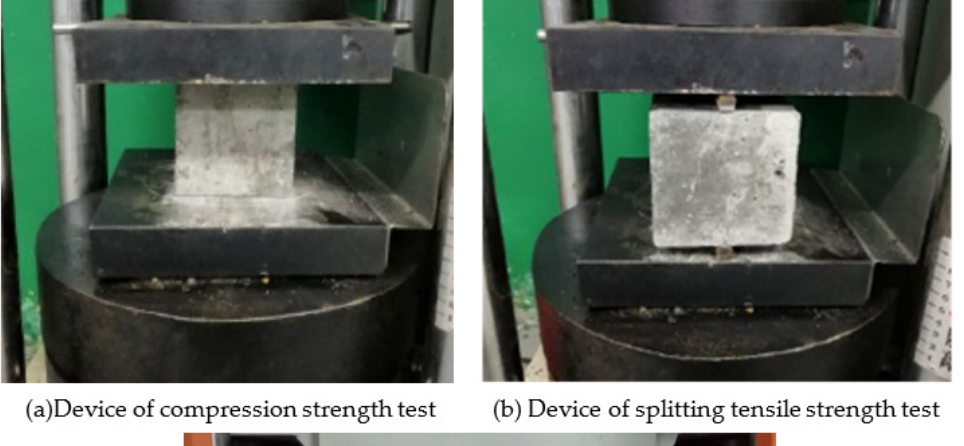
Figure 2. Workability testing.